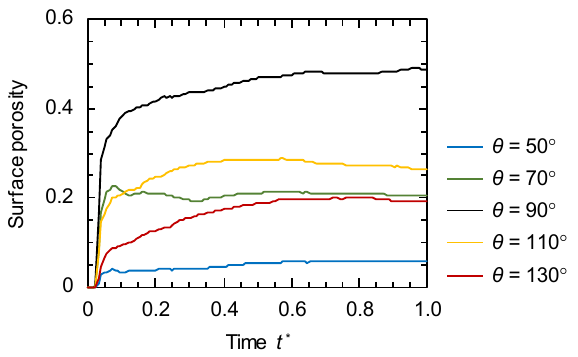
Figure 8. Time variations of surface porosity at θ = 50°, 70°, 90°, 110°, and 130°.